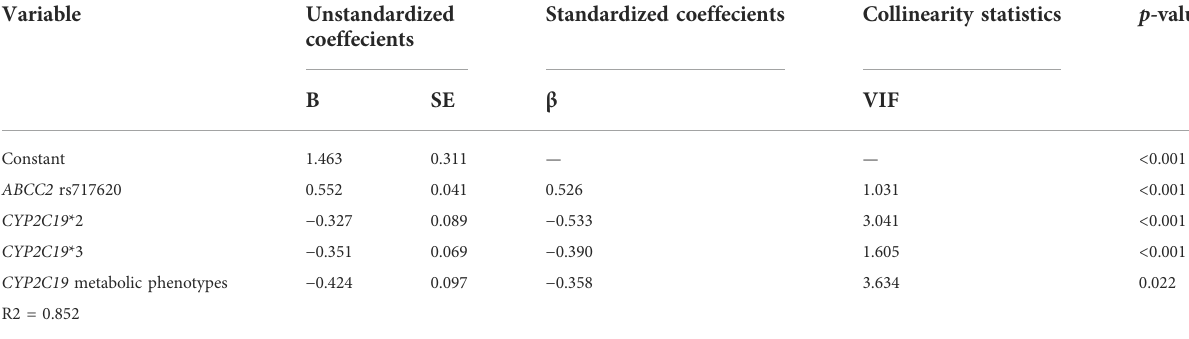
TABLE 2 Relationship between PAIR% values and clinical variables based on stepwise linear regression analysis.